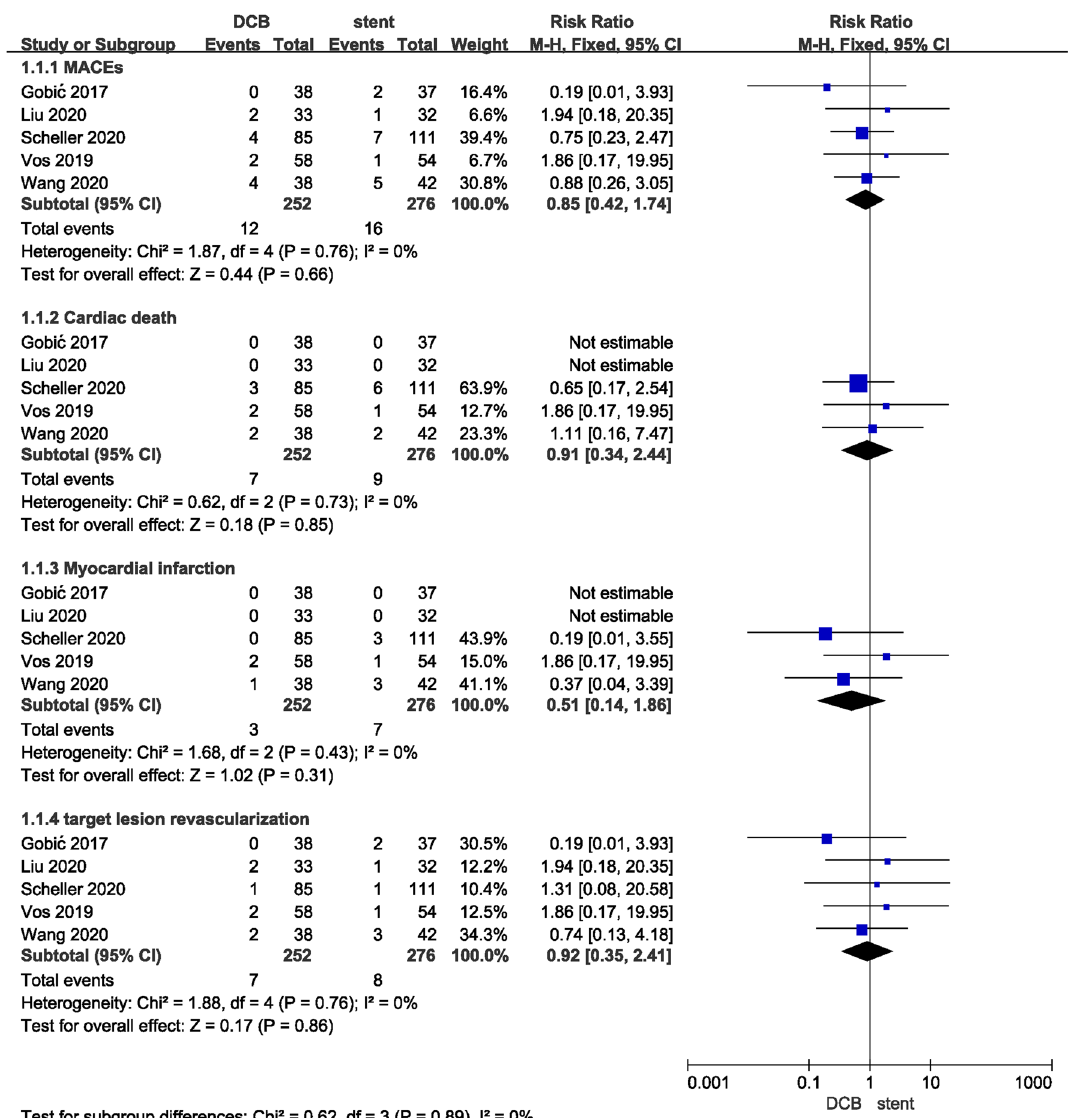
Figure 3. Risk Ratio (RR) of major adverse cardiac events (MACEs).